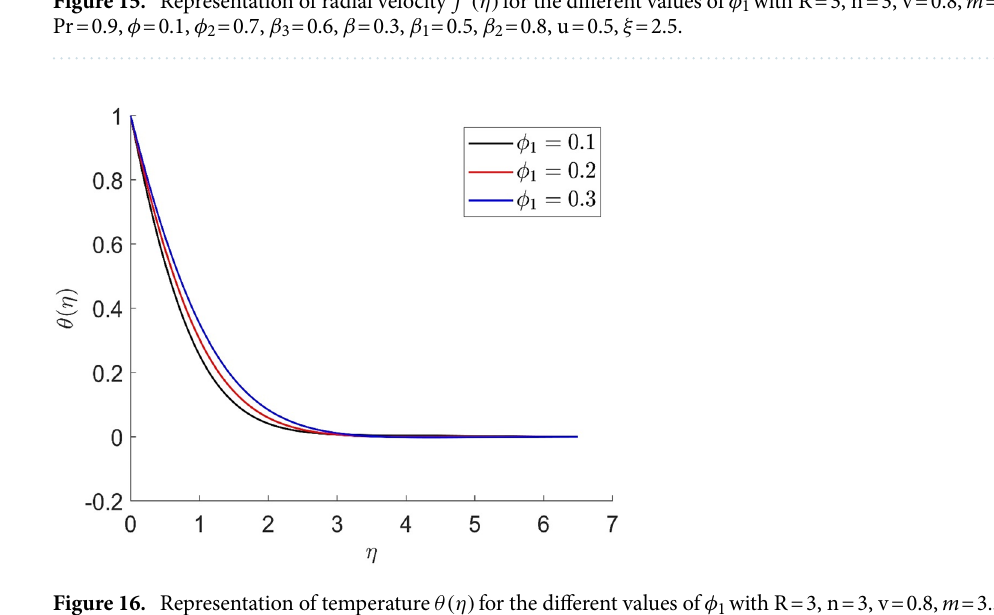
Figure 16. Representation of temperature θ(η) for the different values of φ 1 with R = 3, n = 3, v = 0.8, m = 3.5, Pr = 0.9, φ = 0.1, φ 2 = 0.7, β 3 = 0.6, β = 0.3, β 1 = 0.5, β 2 = 0.8, u = 0.5, ξ =